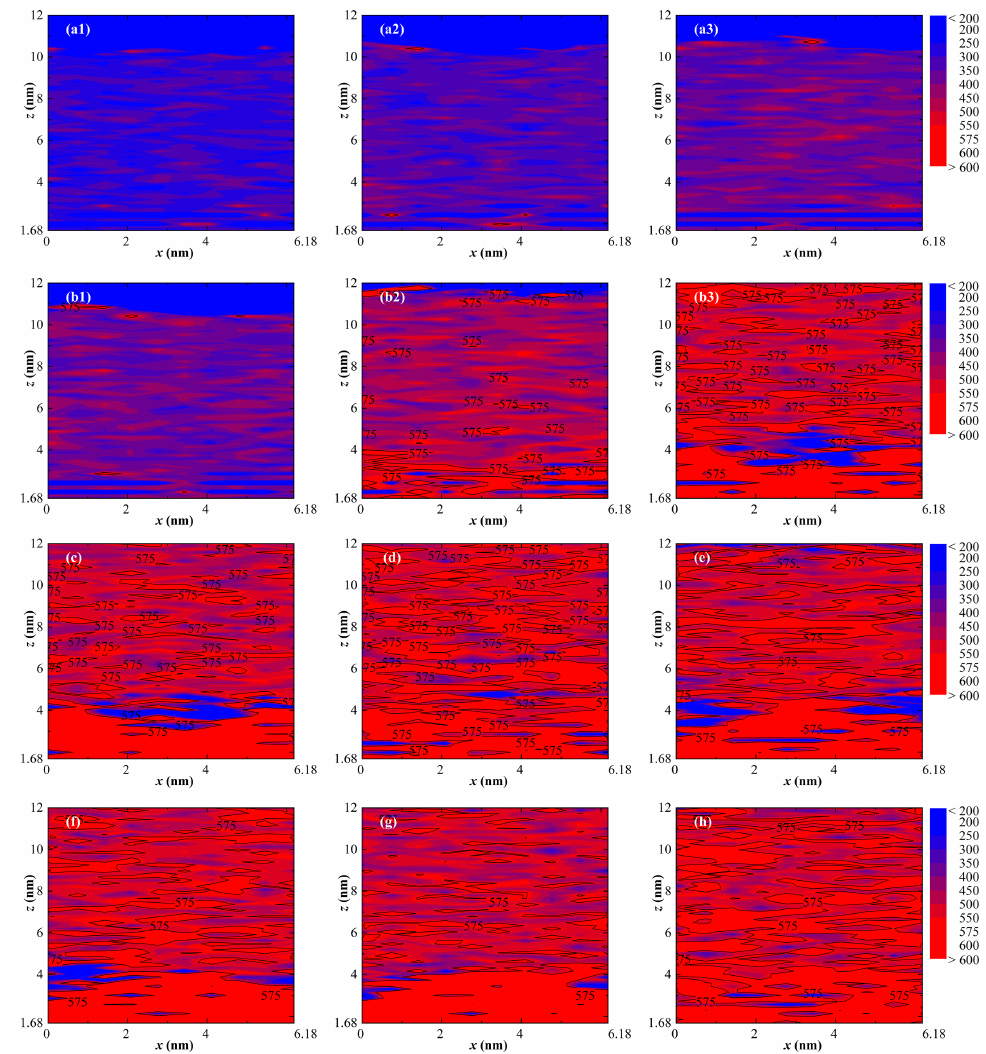
Figure 8. Two-dimensional distribution of temperature at representative time points for cases ( a1 ) no. 5 (Surface − 1, (cid:101) 0 , q 0 ) at 0.01 ns, ( a2 ) no. 5 (Surface − 1, (cid:101) 0 , q 0 ) at 1 ns, ( a3 ) no. 5 O − Cu O − Cu (Surface − 1, (cid:101) 0 , q 0 ) at 1.76 ns, ( b1 ) no. 8 (Surface − 1, (cid:101) 0 , 6 q 0 ) at 0.01 ns, ( b2 ) no. 8 O − Cu O − Cu (Surface − 1, (cid:101) 0 , 6 q 0 ) at 1 ns, ( b3 ) no. 8 (Surface − 1, (cid:101) 0 , 6 q 0 ) at 1.76 ns, ( c ) no. 4 (Surface − 1, O − Cu O − Cu 0.75 (cid:101) 0 , 6 q 0 ) at 1.66 ns, ( d ) no. 12 (Surface − 1, 2 (cid:101) 0 , 6 q 0 ) at 2.05 ns, ( e ) no. 19 (Surface 1, (cid:101) 0 , O − Cu O − Cu O − Cu 3.5 q 0 ) at 3.15 ns, ( f ) no. 20 (Surface 1, (cid:101) 0 , 6 q 0 ) at 1.9 ns, ( g ) no. 16 (Surface 1, 0.75 (cid:101) 0 , 6 q 0 ) at O − Cu O − Cu 1.68 ns, and ( h ) no. 24 (Surface 1, 2 (cid:101) 0 , 6 q 0 ) at 2 O − Cu